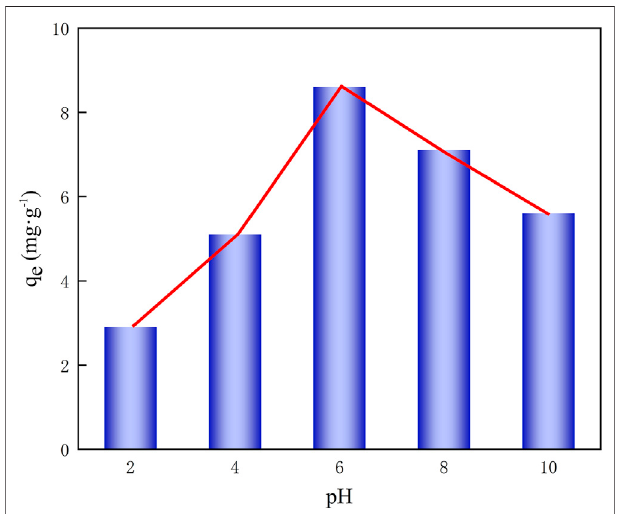
FIGURE 4 | In fl uences of the pH value on the adsorption capacity of PAN-CE@SiO 2 /zeolite for Li( Ι ).